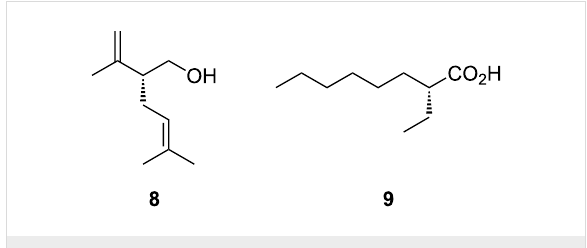
Figure 1: Natural products prepared by